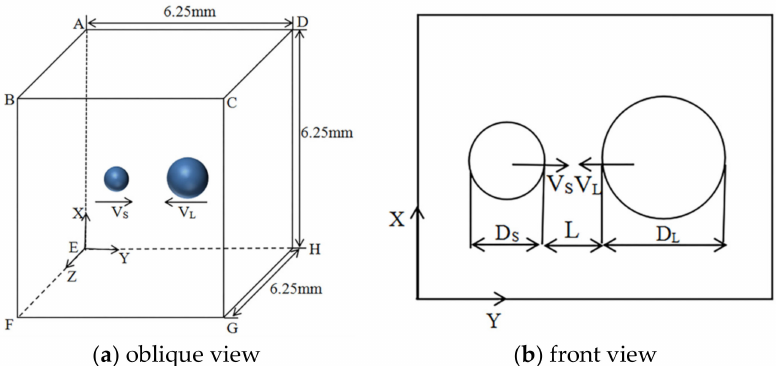
Figure 1. Schematic of the computational domain and the initial state of binary droplets. ( a ) the oblique view, and ( b ) the front